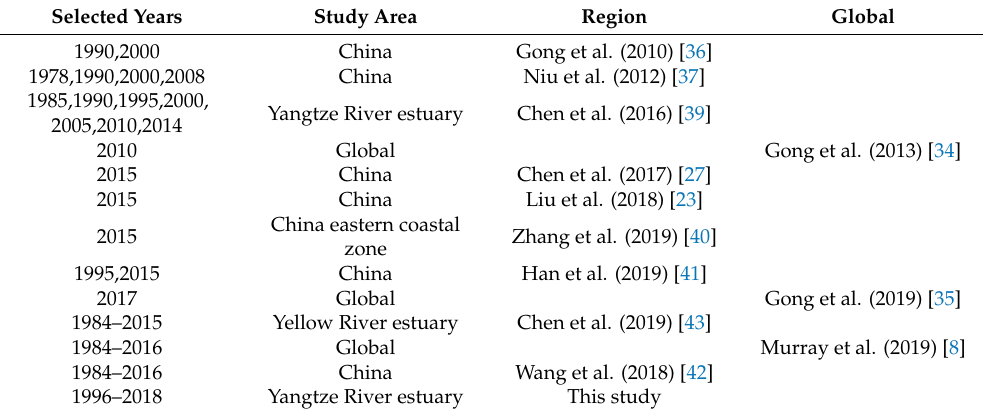
Table 1. A summary on remote sensing research and maps on coastal wetlands in China in the past 10